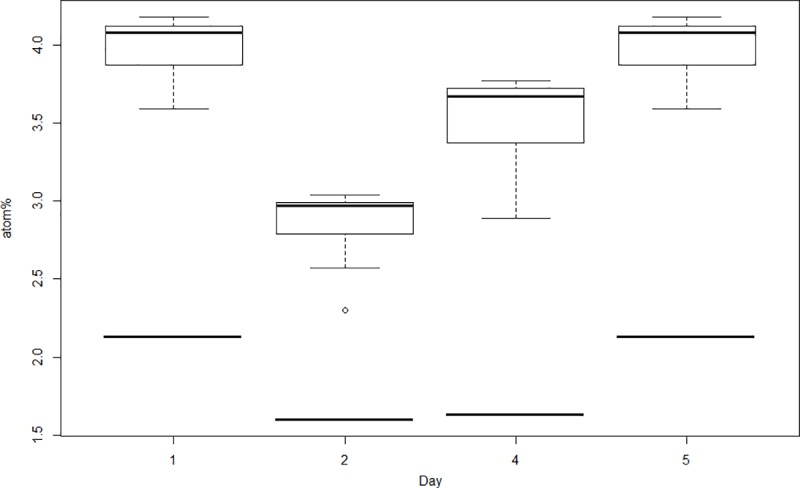
13C isotopic enrichment (atom%) of C. weissflogii daily batch cultures fed to polychaete larvae during the experiment.Straight lines represent atom% values for the fatty acid (FA) 18:0, whereas boxplots and open circles represent average atom% values from all the other FAs. The minimum and maximum observation values are represented by the lower and upper whiskers (respectively), the first and third quartiles are represented by the lower and upper hinges (respectively), and the median is shown as the line that divides the box.